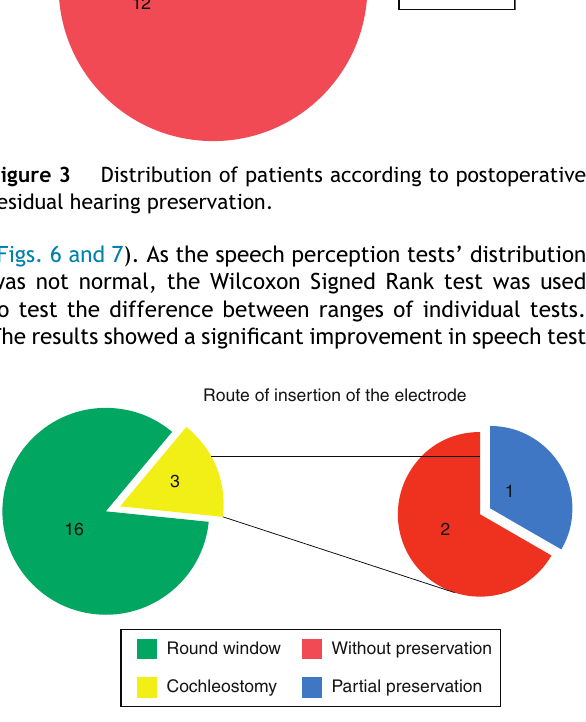
Distribution of patients according to the route of insertion of the electrode and hearing preservation rate of patients undergoing